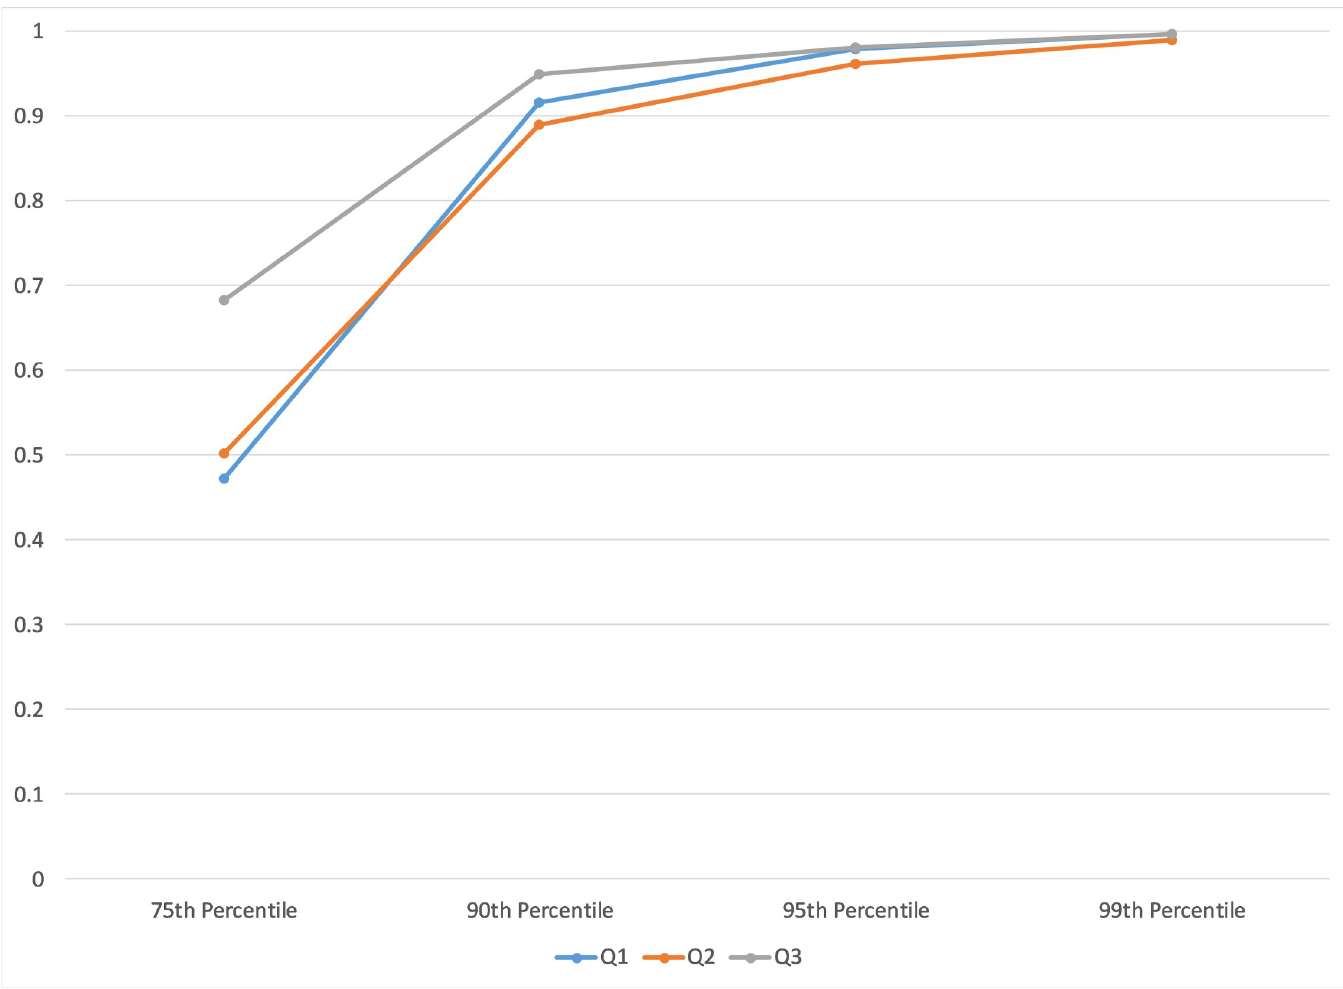
Fig 4. Probability establishment is a substantive innovator for 75 th -99 th percentile by arts-design index bins (Q1-Q3).